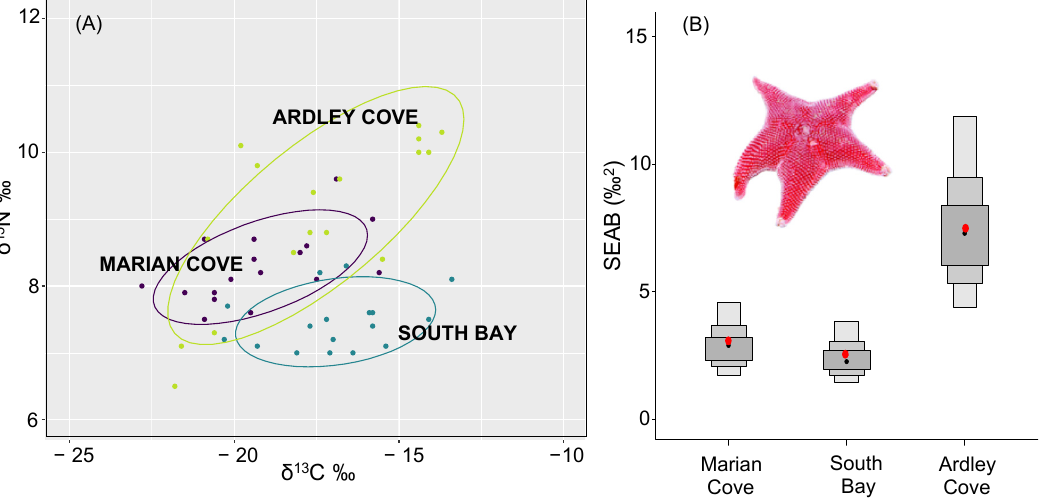
Figure 3. In the left panel, ( A ) solid lines enclose the standard ellipse areas corrected for the sample size (SEAc) of O. validus populations from Ardley Cove, Marian Cove and South Bay. The right panel ( B ) shows the standard ellipse area Bayesian estimations (SEAB) for each population. Black dots show the SEAB mode, red dots represent the SEAC, and gray boxes the probability of data distribution (50% dark grey boxes, 75% light grey boxes and 95% lighter grey boxes).